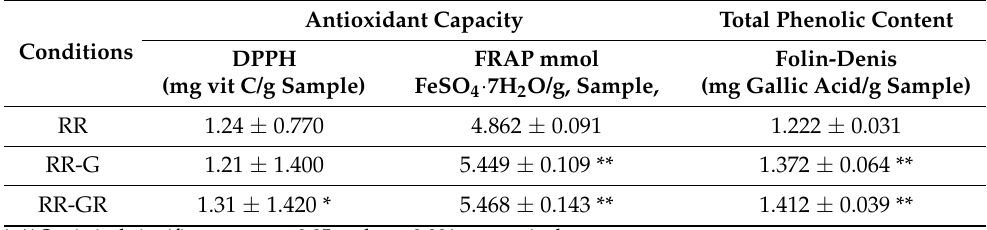
Table 2. Antioxidant capacity and total phenolic content were represented in the results of riceberry rice (RR), riceberry rice with germination (RR-G), and riceberry rice with germination and radiation (RR-GR).